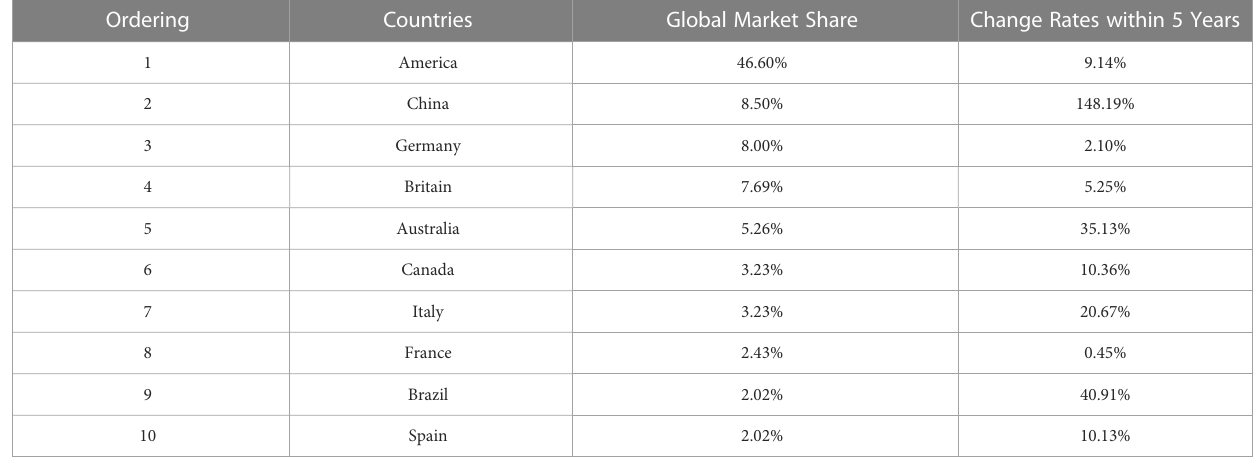
TABLE 1 The distribution of world cruise tourists in 2018.